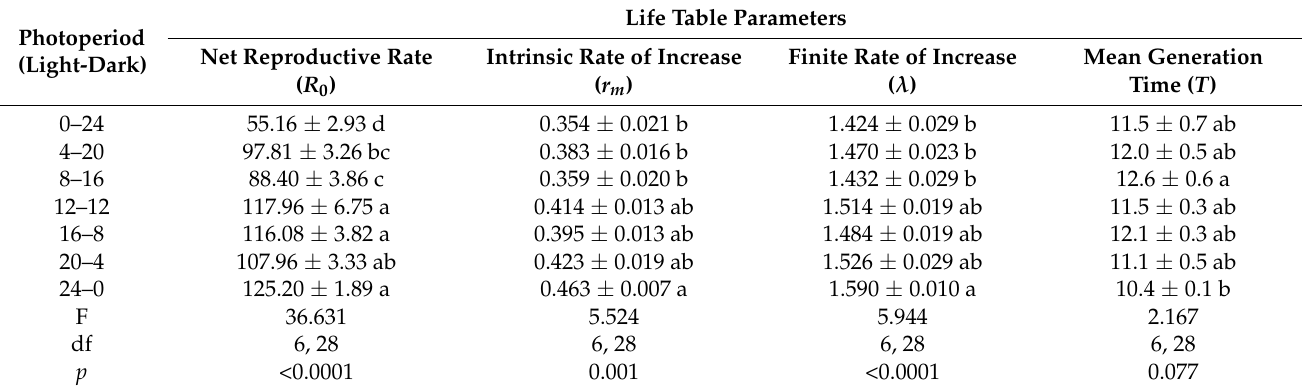
Table 1. Life table parameters of T. remus on S. litura eggs under different photoperiods ( n = 5).